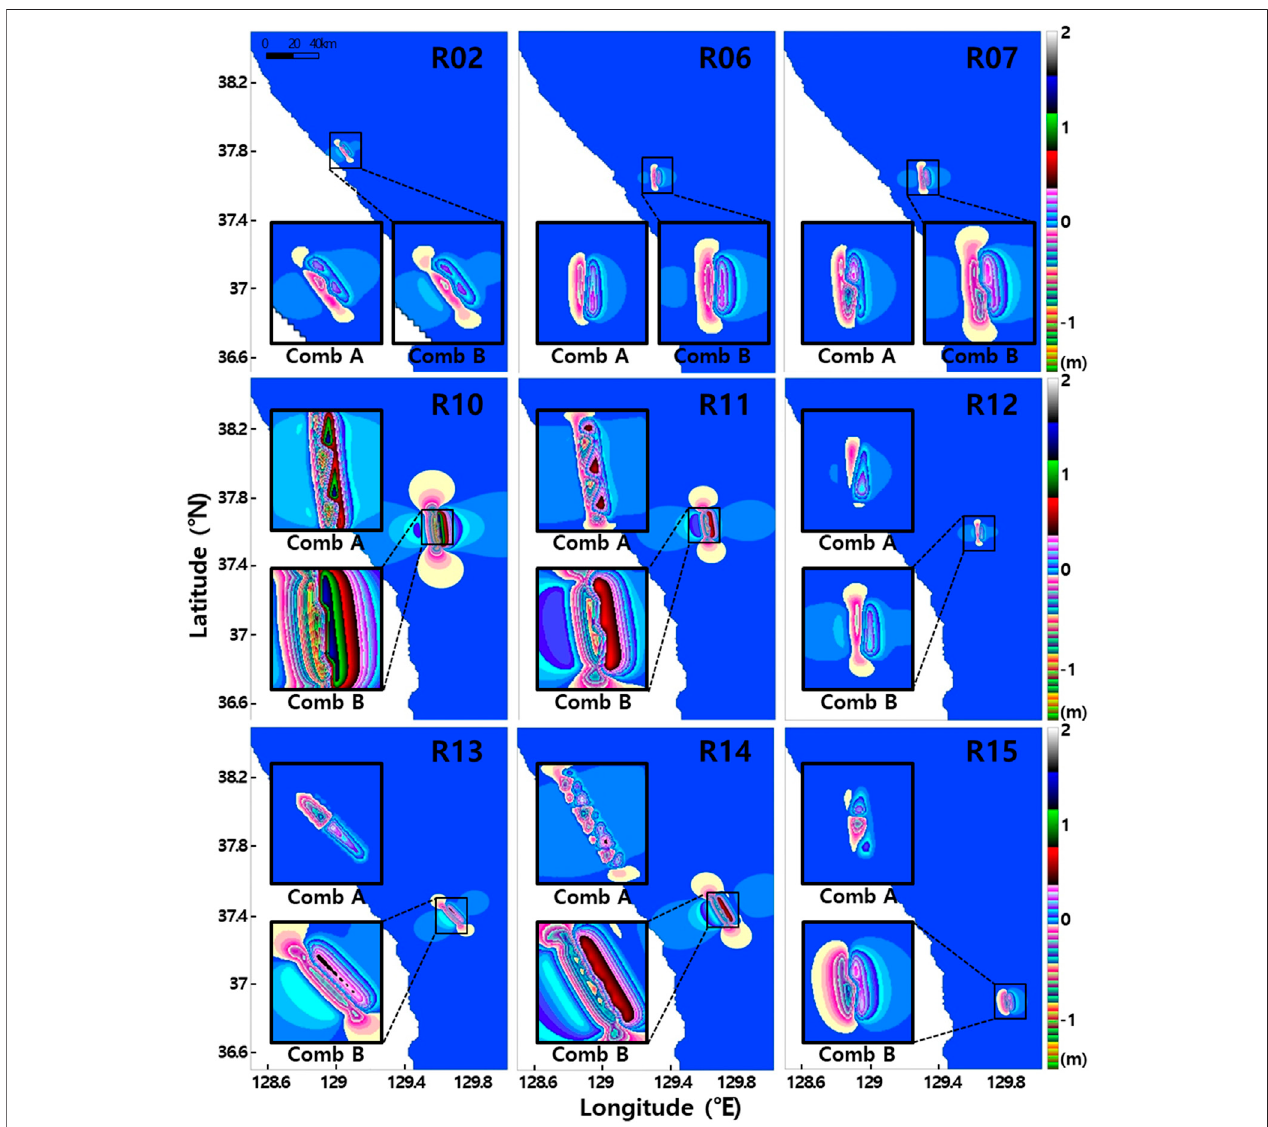
FIGURE4| Theinitialseasurfacedisplacementaccordingtovariationsinfaultparameters(see Section2.2 fordetails). “ Comb ” is “ combination ” (see Section3.1 for details). “ R ” refers to scenario (fault zone) number.